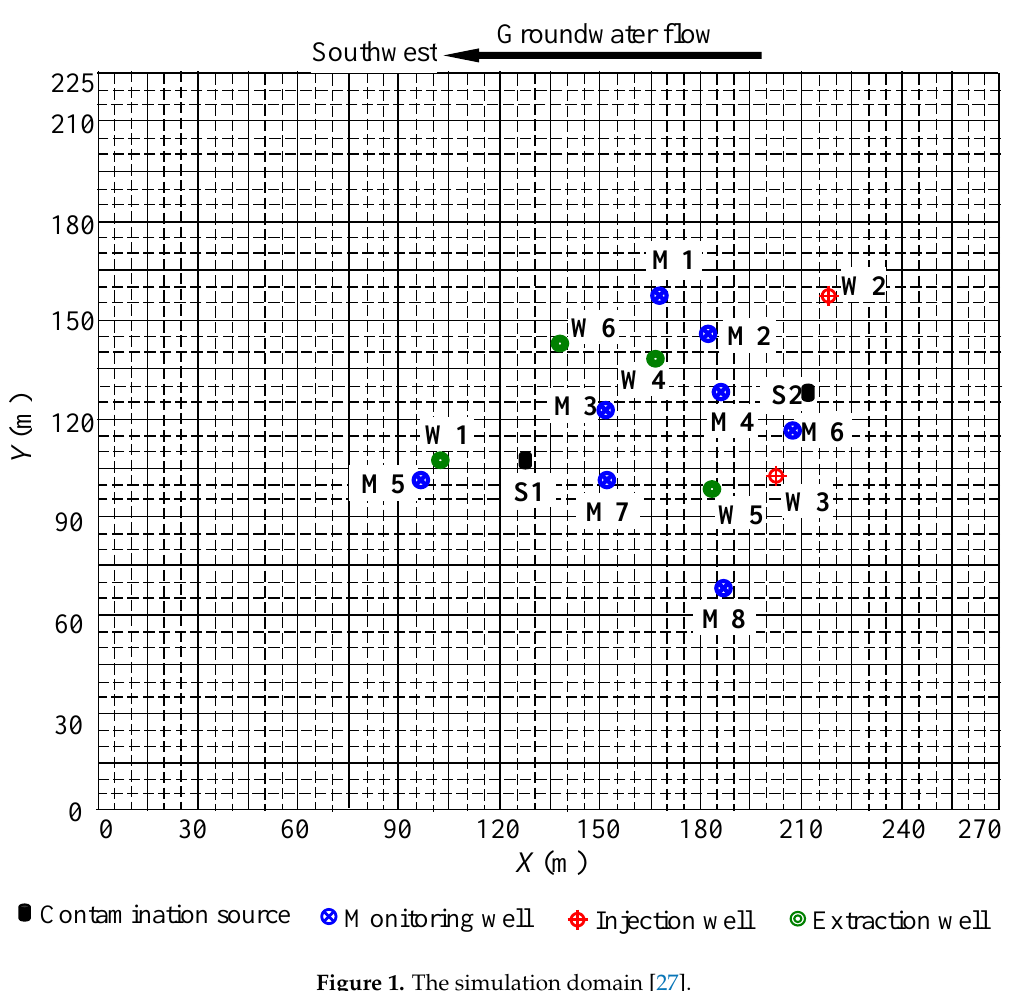
Figure 1. The simulation domain [27].